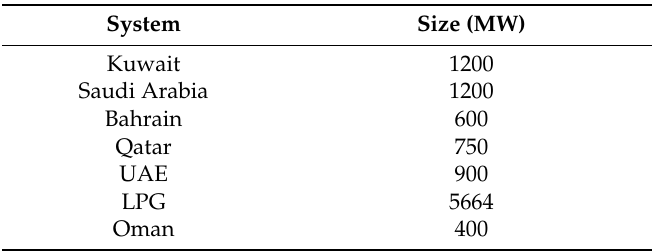
Table 3. Size of interconnection to each Gulf Cooperation Council (GCC) State [35].